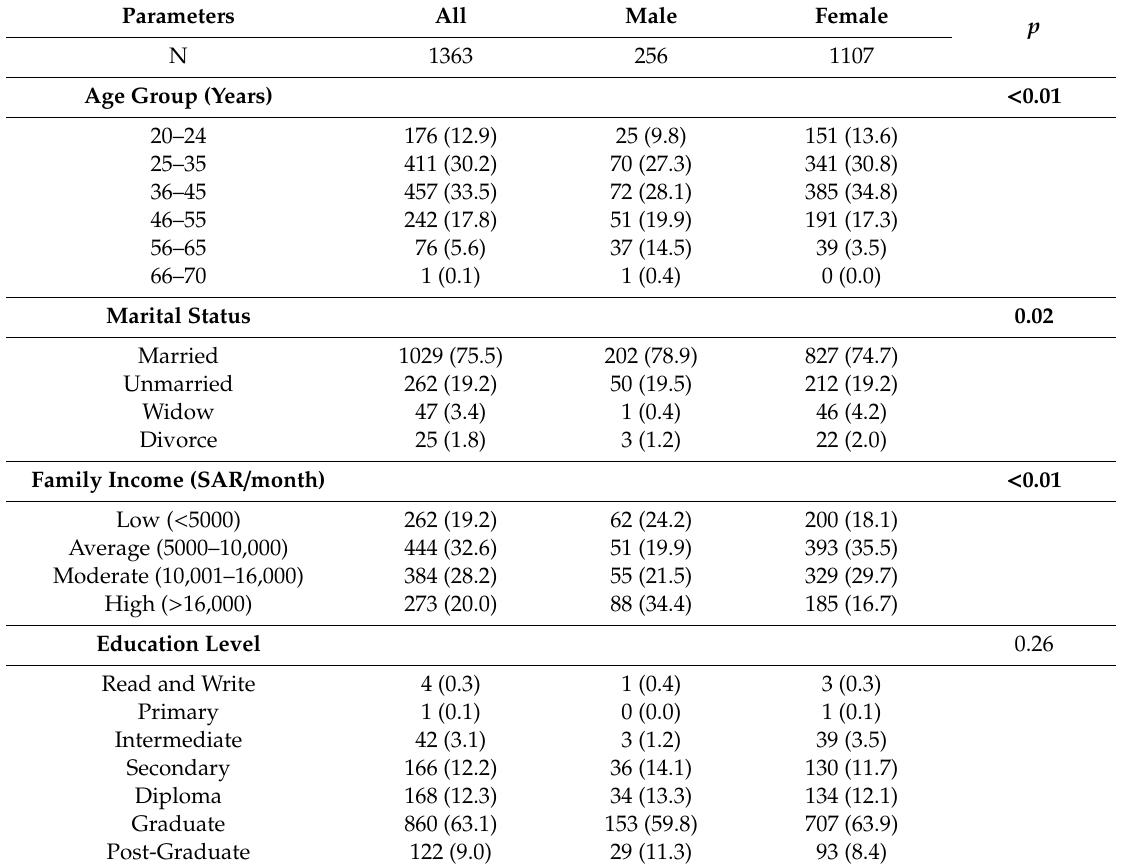
Table 1. Socio-demographic characteristics of the study